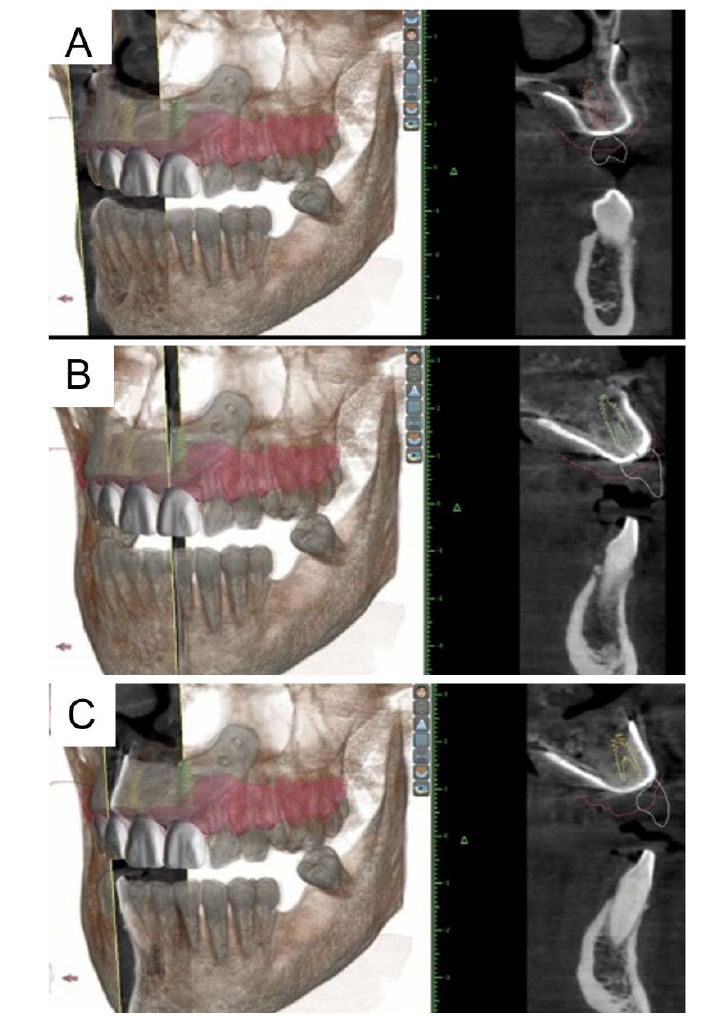
Figure 9. The cross−section CBCT images relative to the second premolar ( A ), right lateral ( B ) and left central incisors ( C ) location in the second case after a month of healing.